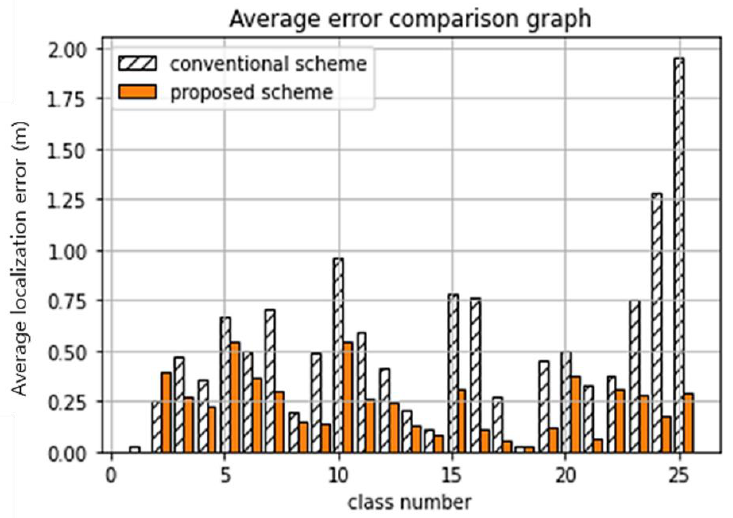
Figure 13. Comparison of localization errors for the conventional scheme and the proposed scheme using two channels.